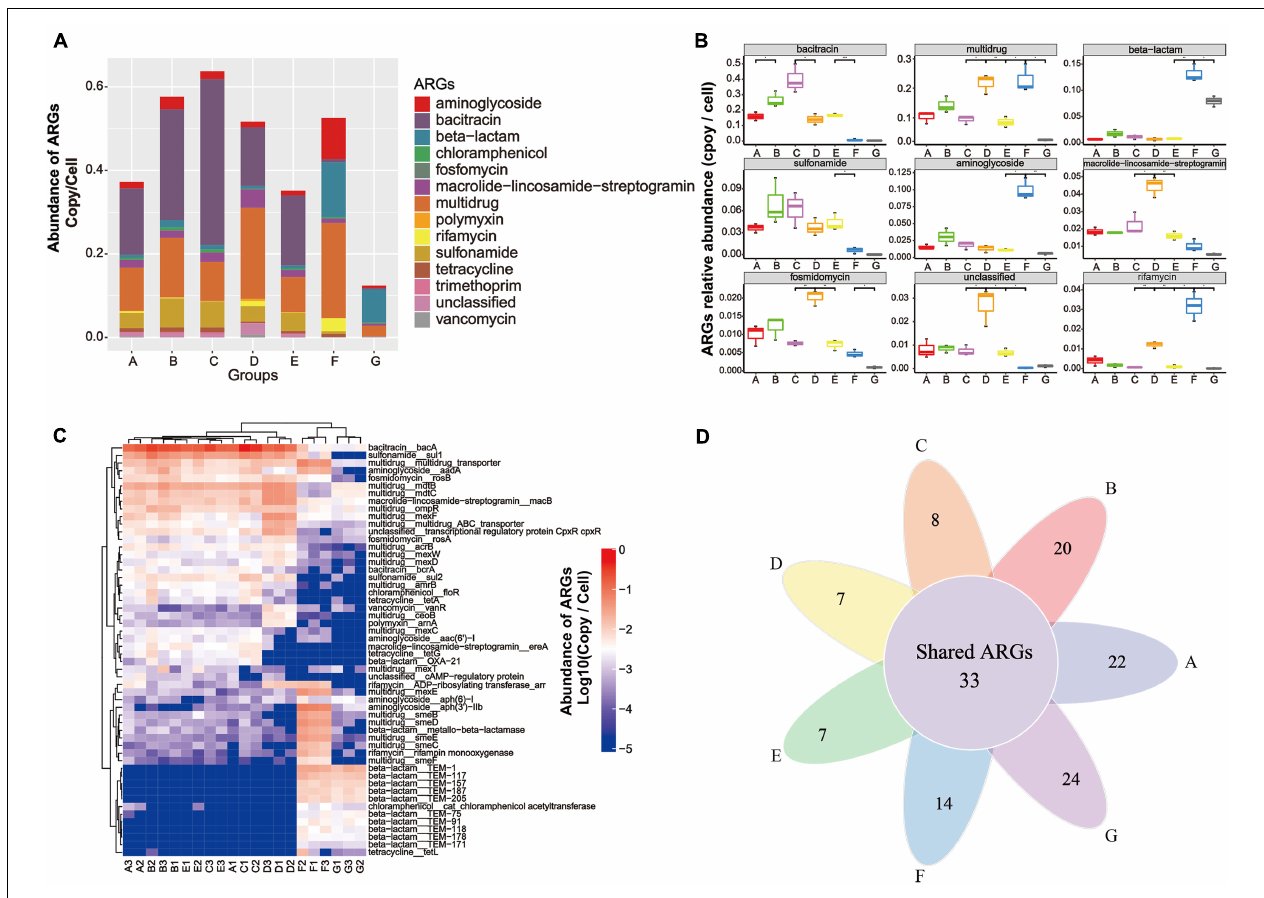
FIGURE 3 | Occurrence and abundance of ARG types and ARG subtypes in the DWTS bulk water and sand biofilm. (A) Characterization of ARG types and abundance. (B) Boxplots showing the number of detected ARG types in the DWTS bulk water and sand biofilm. (C) Occurrence and fate of the top 20 ARG subtypes in the DWTS bulk water and sand biofilm. (D) Venn diagram of ARGs subtypes in the DWTS bulk water and sand biofilm. A1–A3: raw water; B1–B3: flocculation tank effluent; C1–C3: sedimentation tank effluent; D1–D3: quartz sand; E1–E3: sand filter effluent; F1–F3: chlorine-disinfected water; G1–G3: tap water. Three samples were taken from each sampling